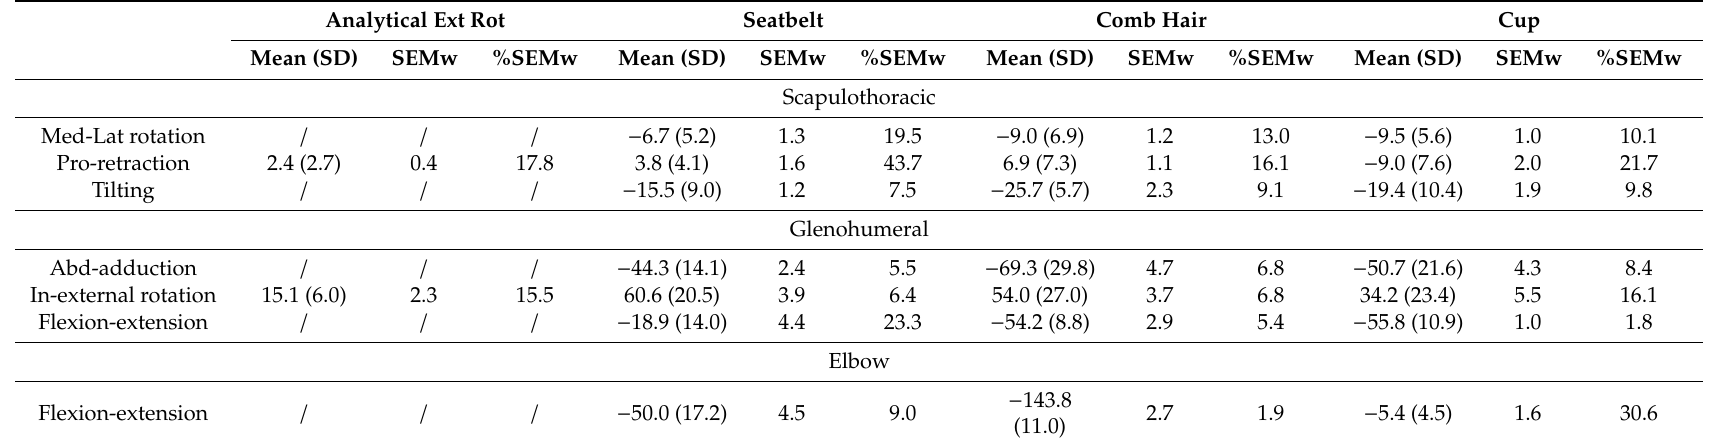
Table 2. Within-session means, standard deviations, and standard error of measurements, expressed in degrees. Analytical Ext Rot Seatbelt Comb Hair